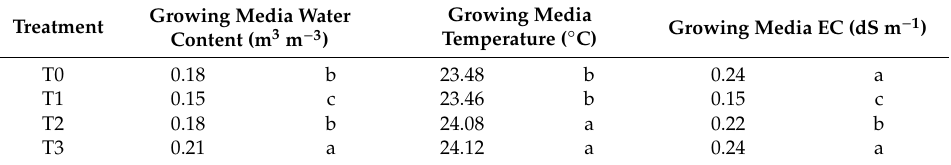
Table 2. Mean physical parameters of the growing media recorded in the compared thesis during the trial.